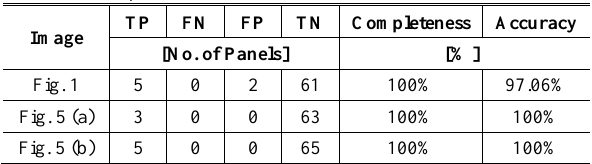
Figure 7. Result of algorithm implementation to the image in Figure 5 (b) Table 1. Comparison of fault detection accuracies